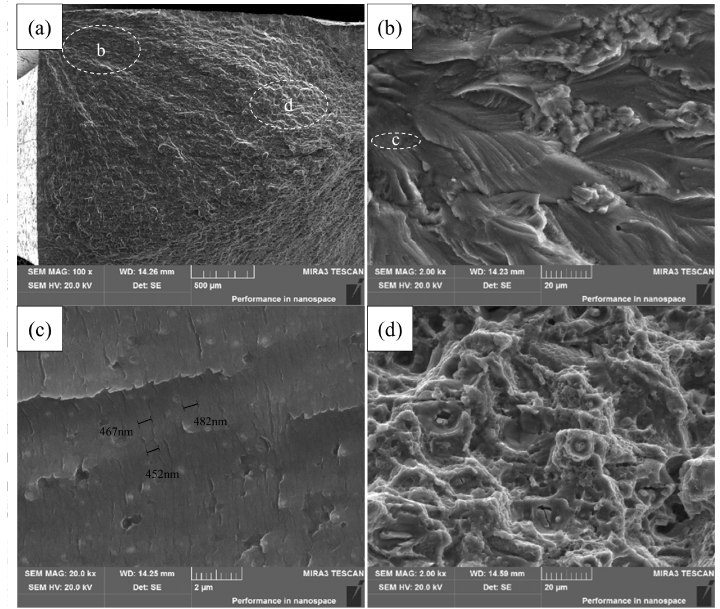
Figure 9. The fatigue fracture surfaces of Al-Cu-Mg alloy under 0 MPa after 12 h of creep aging at 180 ◦ C: ( a ) full view; ( b ) fracture nucleation; ( c ) stable fatigue crack growth; ( d ) final